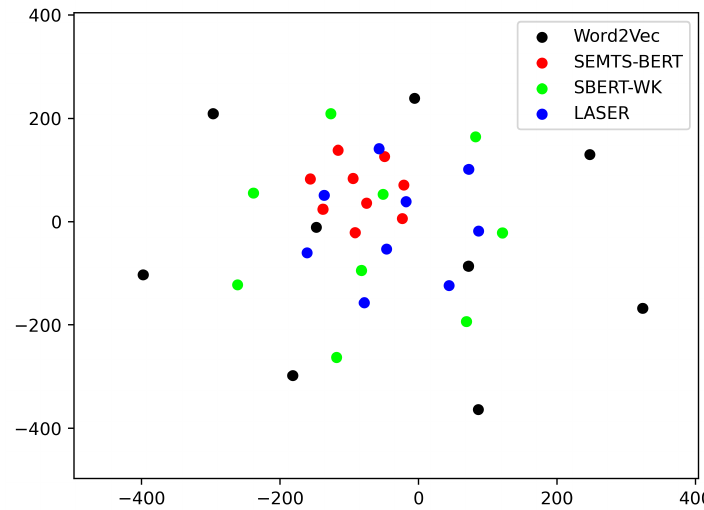
Figure 10. The relative distance between the Chinese low-frequency words. We use t-SNE (initialized by PCA) for dimensionality reduction so that the high-dimensional embeddings can be shown on a two-dimensional plane